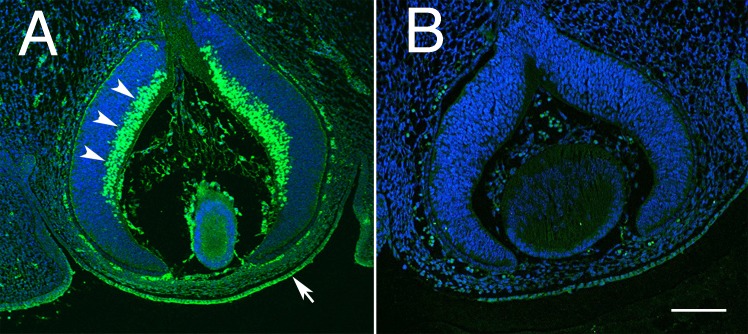
Distribution of POU6F2, in the embryonic eye P15 is illustrated.In sections stained for POU6F2 (A), there is prominent staining of neuroblasts destined to become retinal ganglion cells (arrow heads). There is also staining of the developing cornea and corneal epithelium (arrow). This staining is specific to the primary antibody for it is not present in sections in which the primary antibody was omitted (B) a secondary only control. Both sections are at the same magnification and the scale bar in B represents 100μm.